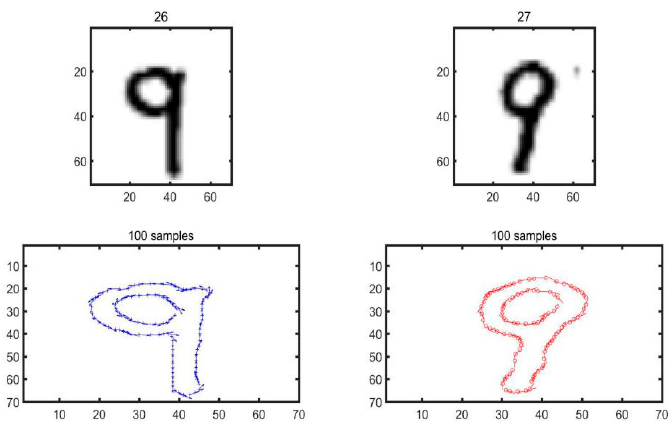
Figure 6. Feature points of the handwritten number ‘9’.